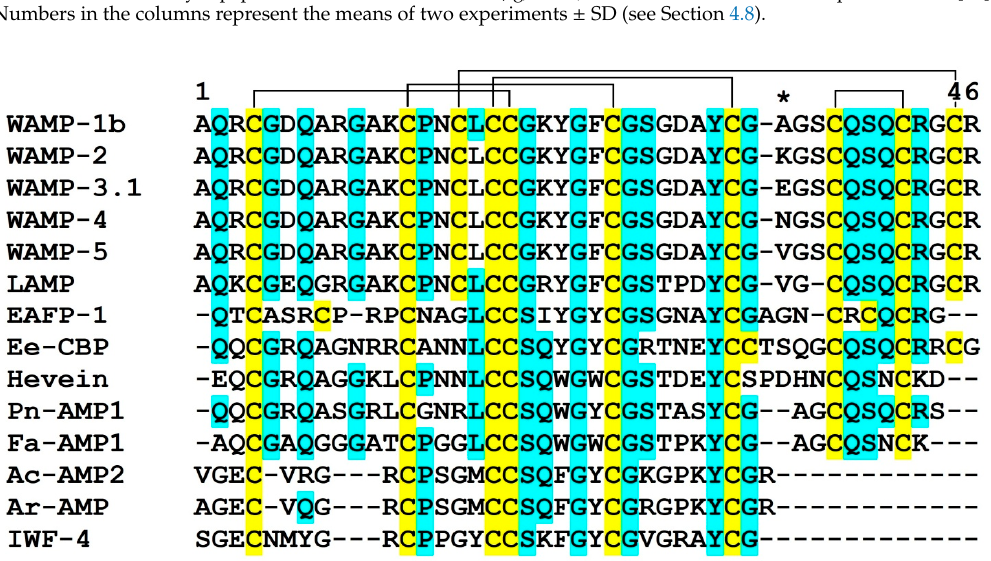
Figure 2. The spatial structure of WAMP-1a (PDB 2LB7) and 3D structure models of WAMP homologues. Modeling was carried out using SWISS-MODEL [37]. The residue at position 34 is shown in red. Non-polar residues are colored white, and polar residues are colored cyan.